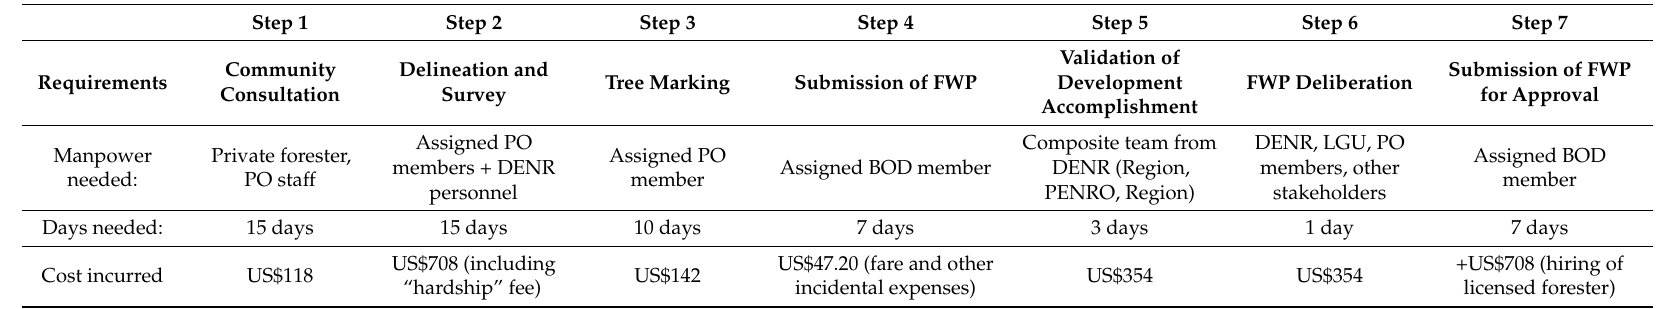
Table 2. Steps and requirements in preparing the five-year work